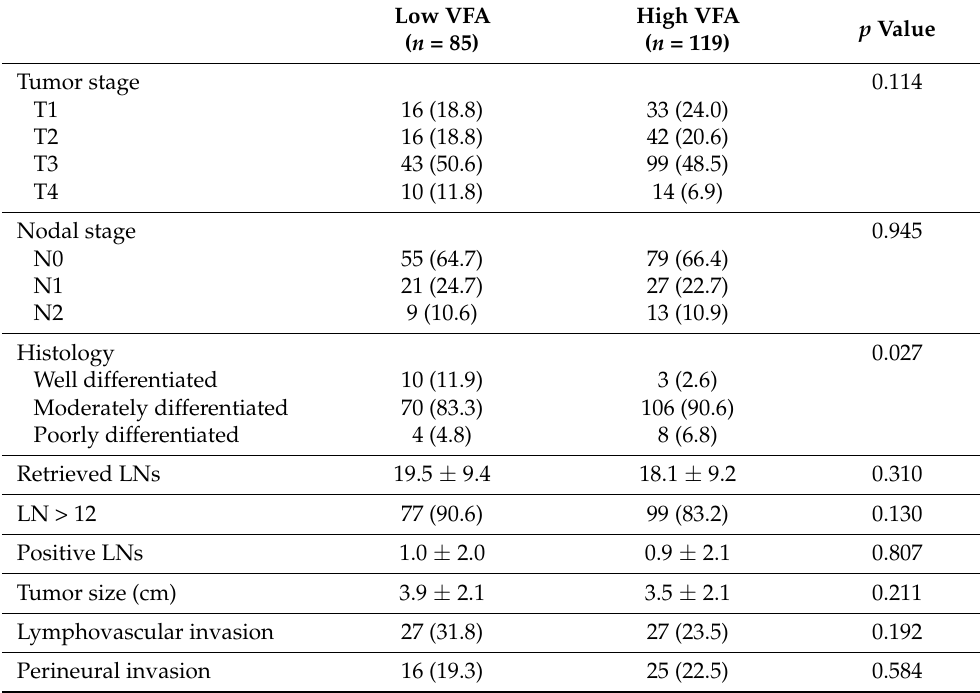
Table 3. Postoperative Pathologic Outcomes.